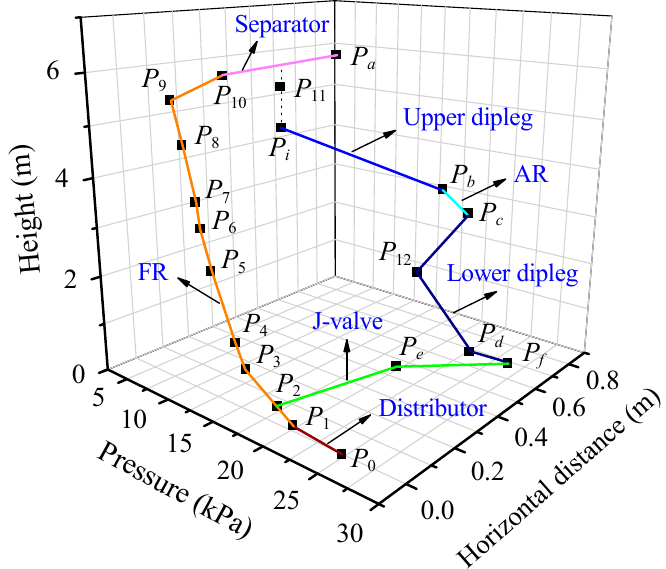
Figure 3. Pressure profile of the iG-CLC system under the reference condition.